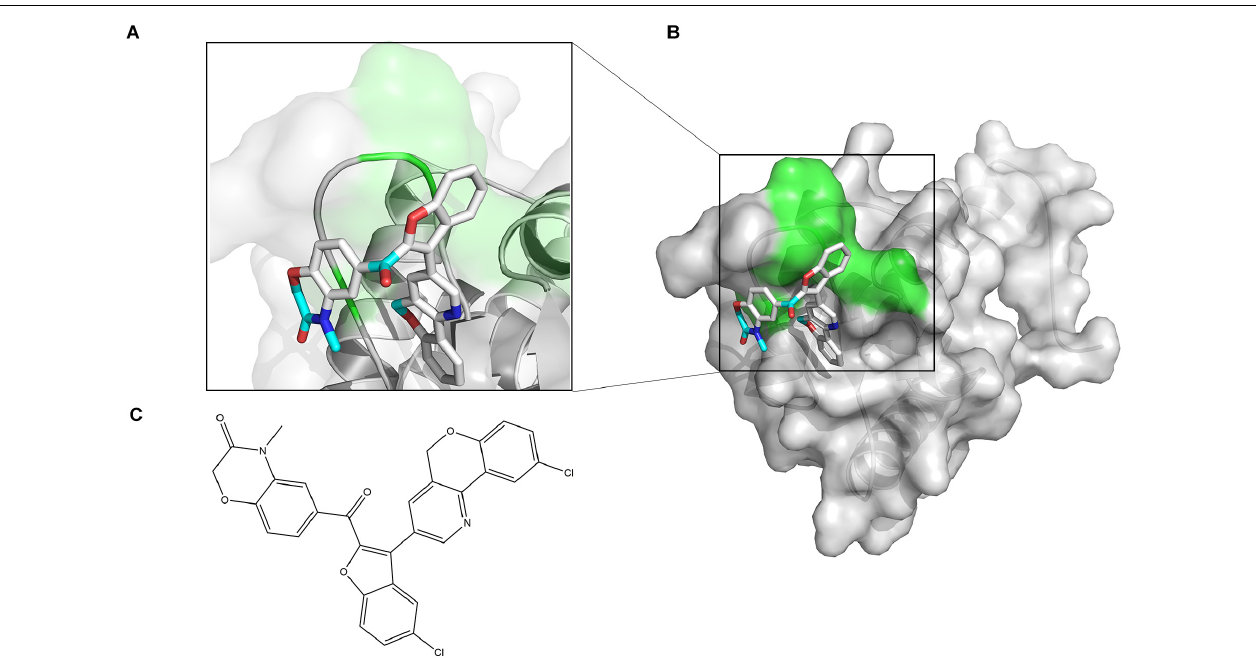
FIGURE 1 | Computational model of compound ZINC00990144 bound to SarA revealed by docking simulations. (A) SarA proteins are shown in cartoon mode with conservative residues marked with green and labeled. ZINC00990144 is displayed as stick. Light blue: carbon, dark blue: nitrogen, gray: hydrogen, and red: oxygen. (B) Protein surfaces are shown in gray and predicted binding sites are marked with green. (C) Structure of ZINC00990144.